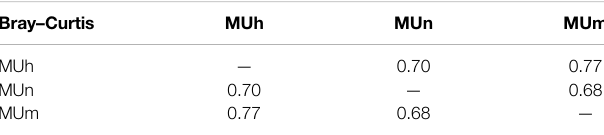
TABLE 2 | Bray – Curtis of EM fungi associated with P. sylvestris in different age groups.